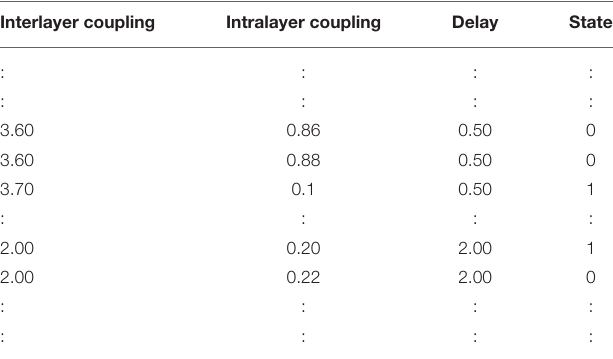
TABLE 6 | Data structure for Solitary data: there are 8,000 rows in total in this table. Interlayer coupling